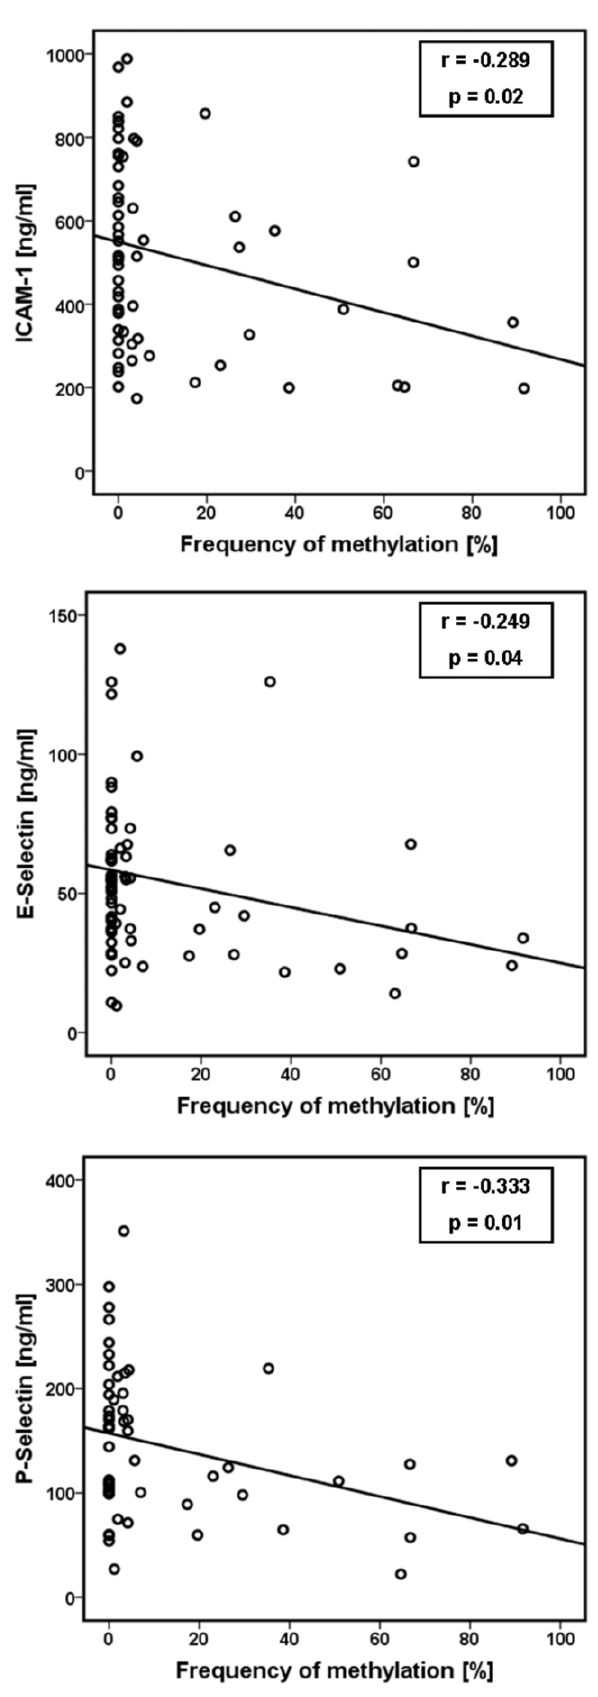
Figure 6. Correlation analysis between the inflammatory marker serum concentrations (baseline) and the ACE methyl- ation frequency over all 24 CpG sites of each probe. We found a significant inverse correlation between the methylation frequency and the serum baseline concentrations of ICAM-1 (r= 2 0.289, p=0.02), E- selectin (r= 2 0.249, p=0.04) and P-selectin (r= 2 0.333, p=0.01); (Pearson’s